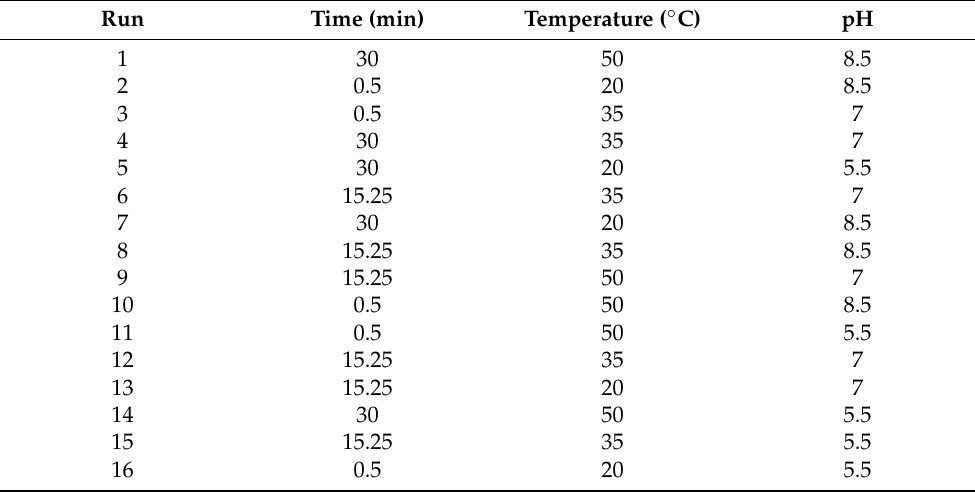
Table 3. Dependent variable conditions for the ultrasound-assisted extraction